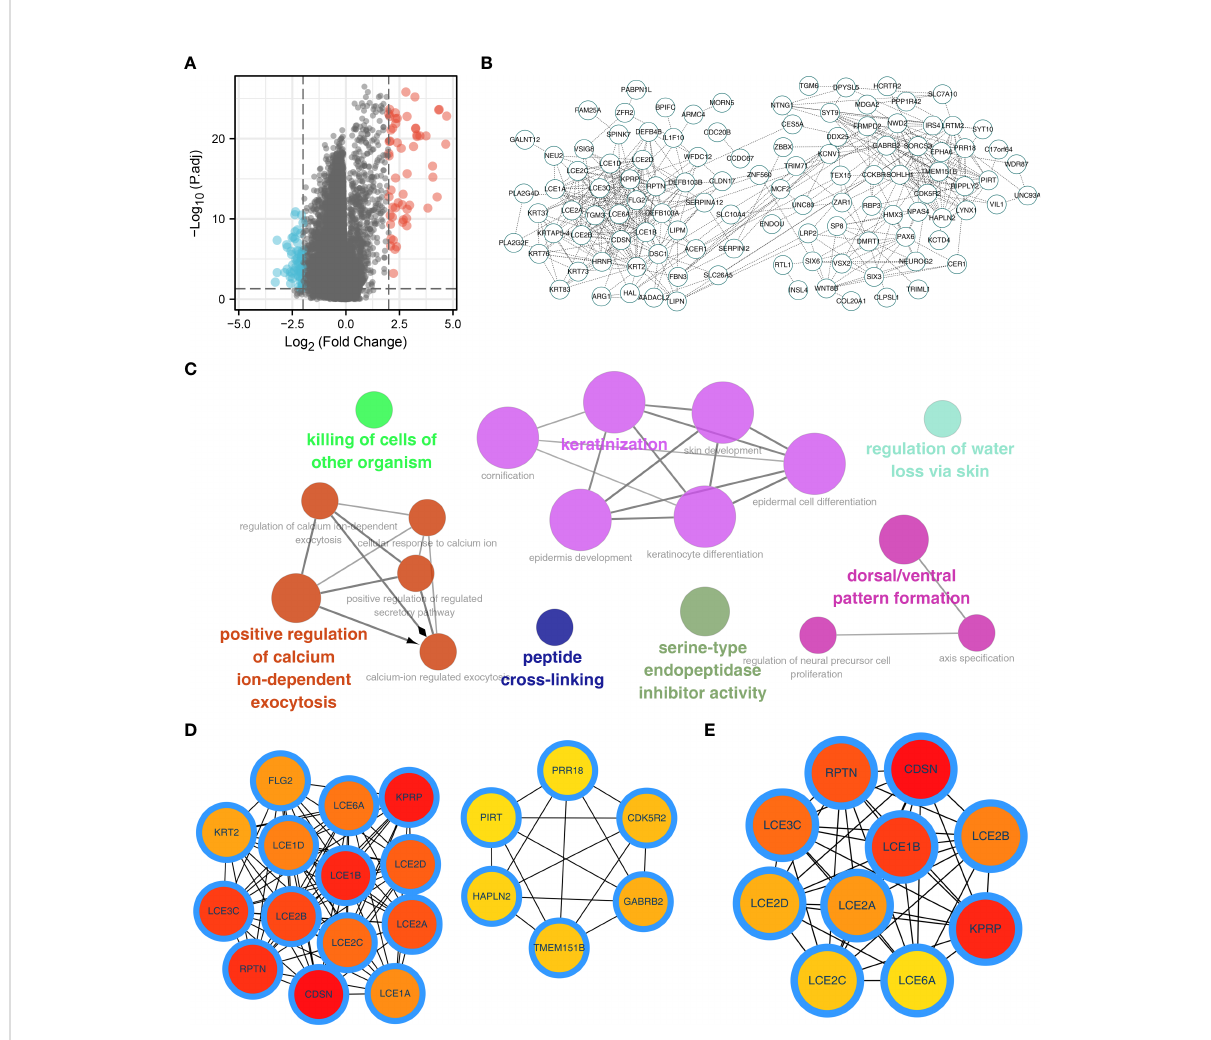
FIGURE 2 Identi fi cation of the DEGs of alpha linolenic acid metabolism. (A) Limma package was used to identify the DEGs between high and low alpha linolenic acid metabolism ; (B) PPI network of the DEGs; (C) ClueGO analysis of the DEGs; (D – E) Top 20 and 10 important nodes of the